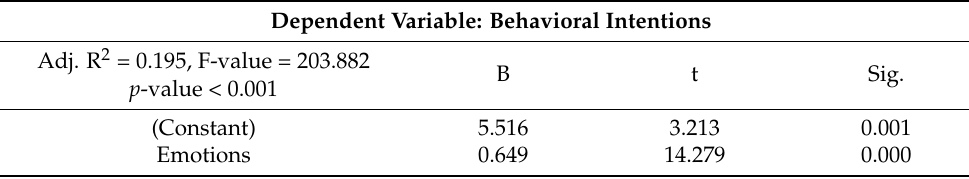
Table 5. Step 1. First simple regression equation of the mediation analysis. Dependent Variable: Behavioral Intentions Adj. R 2 = 0.195, F-value = 203.882 p -value < 0.001